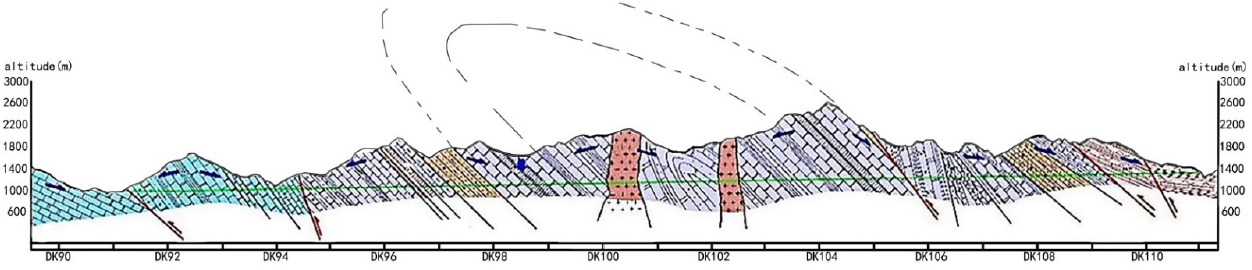
Figure 2. Vertical section of the Yuelongmen Tunnel.